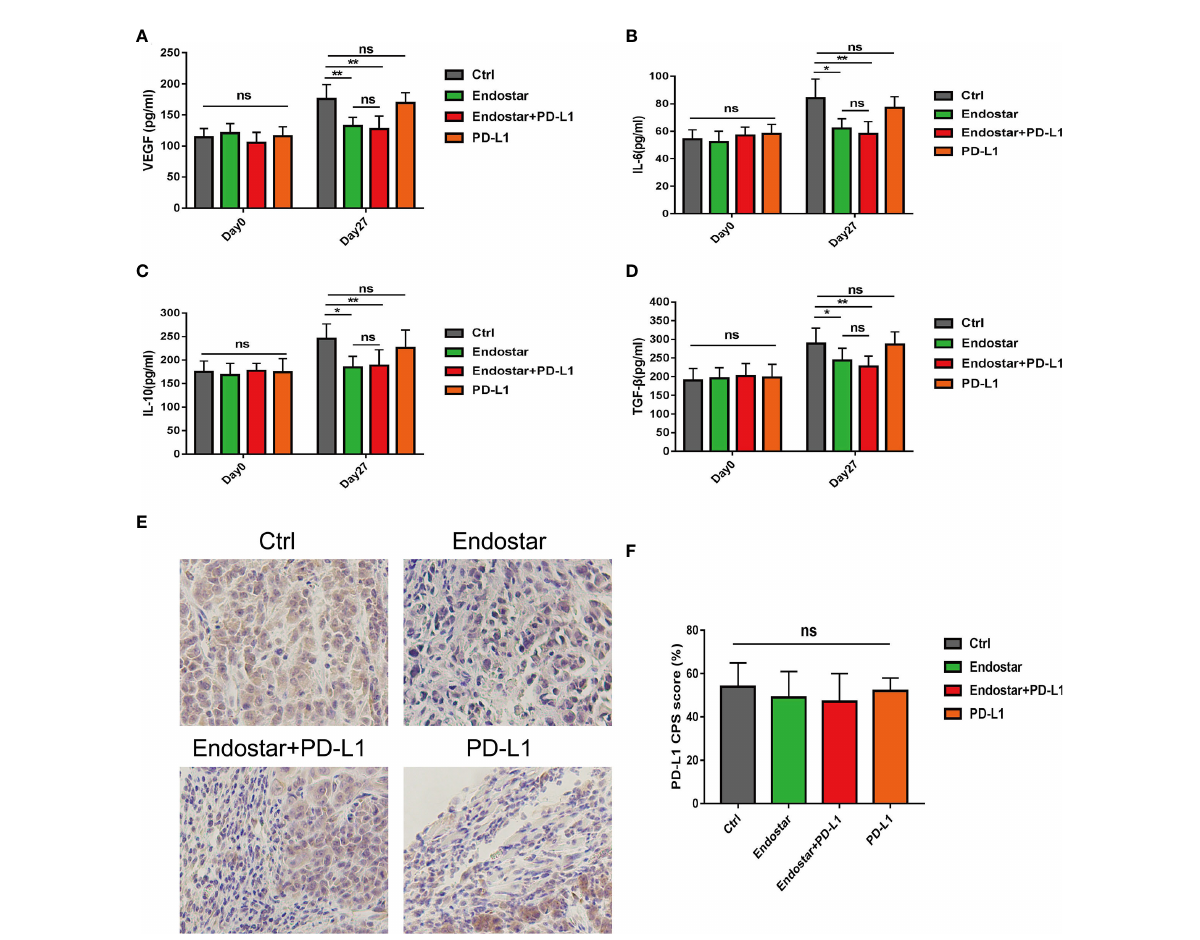
FIGURE 4 Comparison of serum vascular endothelial growth factor (VEGF), interleukin (IL)-6, IL-10, and transforming growth factor (TGF)- b levels between before and 27 days after intervention. (A) Serum vascular endothelial growth factor (VEGF), levels in the control, Endostar, Endostar +programmed death ligand-1 (PD-L1), and PD-L1 groups. (B) Comparison of serum interleukin (IL)-6 levels among the four groups. (C) Comparison of serum interleukin (IL)-10 levels among the four groups. (D) Comparison of serum transforming growth factor (TGF- b ) levels among the four groups. After 27 days of intervention, the expression levels of PD-L1 in tumors of mice in each group were compared. (E) programmed death ligand-1 (PD-L1) expression levels of tumors in mice of the immunohistochemical control (Ctrl), Endostar, Endostar+PD-L1, and PD-L1 groups (×400). (F) Comparison of combined positive score (CPS) scores of PD-L1 expression among the different groups of mouse tumors (ns, Not signi fi cant; P > 0.05). (*P<0.05,